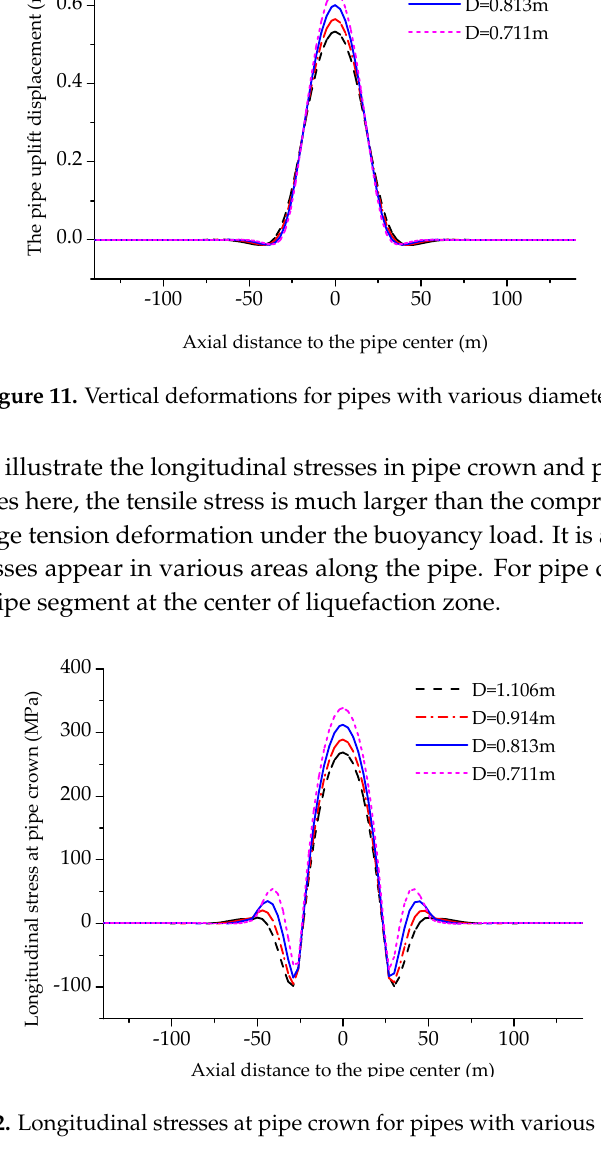
Figure 12. Longitudinal stresses at pipe crown for pipes with various diameters